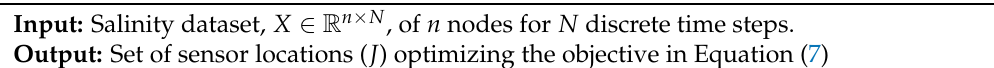
Algorithm 1: Pseudo code of sensor